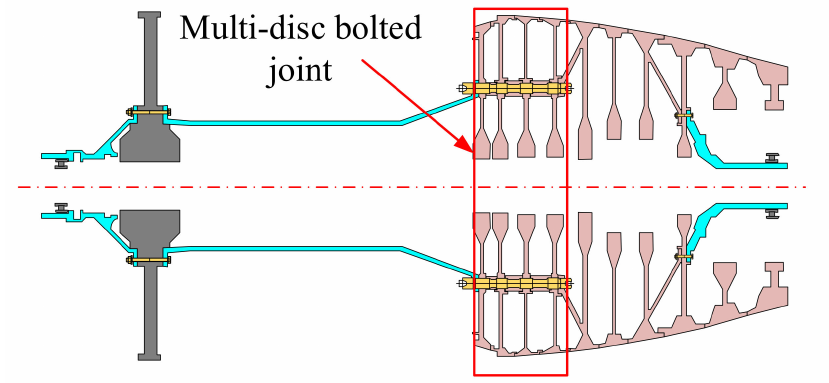
Figure 1. Sketch of a certain type of aero-engine compressor with a multi-disc bolted